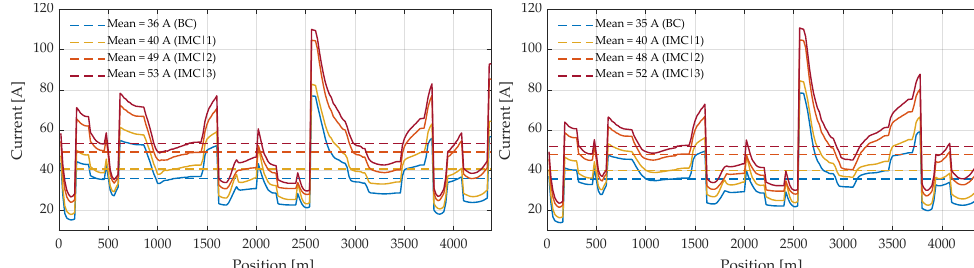
Figure 24. RMS currents (solid lines) along the catenary and its mean value (dashed lines) for the four considered scenarios. Results for the simulations of: 07:00 to 10:00 ( left ), and 17:00 to 20:00 ( right ).